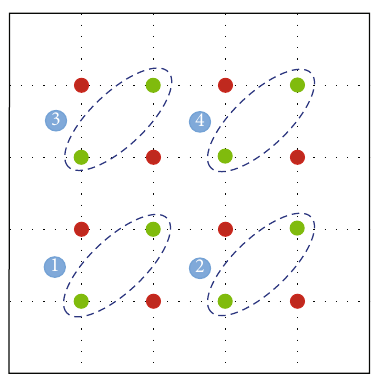
Figure 2: Group ordering for EDG method for N = 5